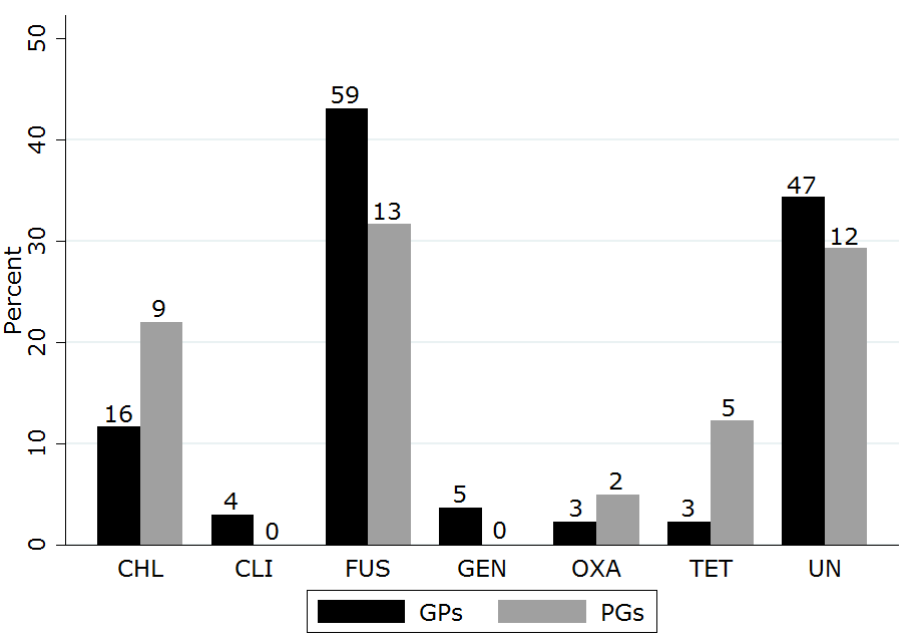
Figure 2. Topical antibiotic choices for FHV ‐ 1 keratitis selected by UK general practitioners and postgraduate groups who suggested topical antibiotic therapy in a questionnaire ‐ based survey (CHL, chloramphenicol; CLI, clindamycin; FUS, fusidic acid; GEN, gentamycin; OXA, oxacillin; TET, tetracyclines; UN, unspecified; numbers indicate number of respondents suggesting treatment).